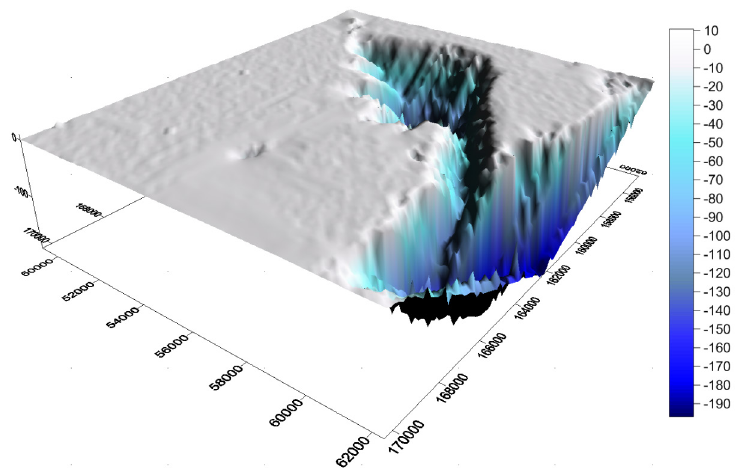
Figure 9. Simulated coastal area of the seabed